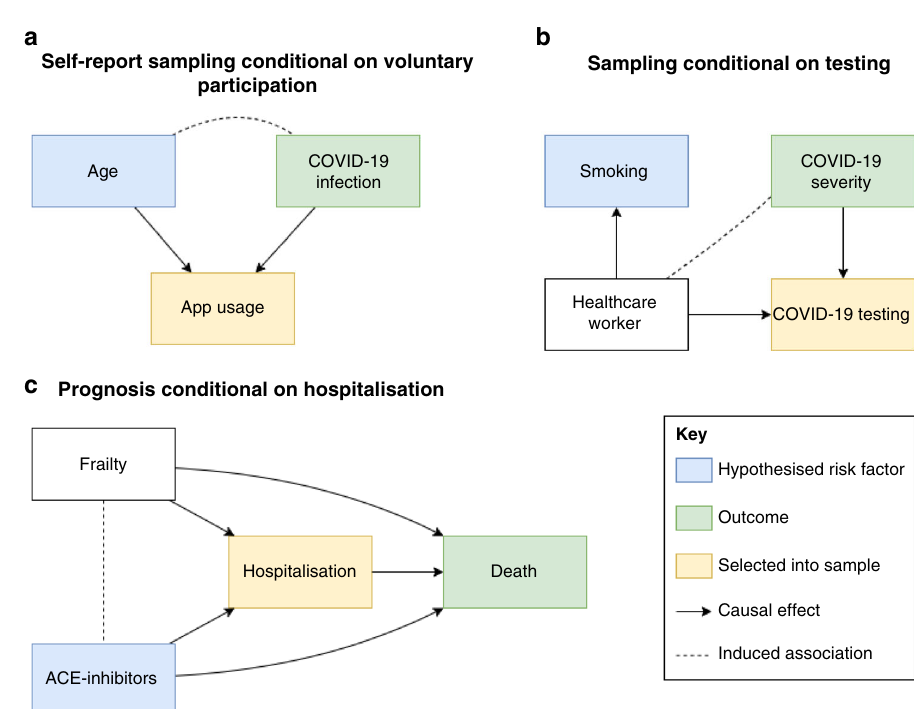
Fig. 2 Collider bias induced by conditioning on a collider in three scenarios relating to COVID-19 analysis. These are simpli fi ed Directed Acyclic Diagrams where only the main variables of interest have been represented for sake of illustrating collider bias scenarios. All assume no unspeci fi ed confounding or other biases. Rectangles represent observed variables and solid directed arrows represent causal effects. The dashed line represents an induced association when conditioning on the collider, which in these scenarios are variables that indicate whether an individual is selected into the sample. a When some hypothesised risk factor (e.g. age) and outcome (e.g. COVID-19 infection) each associate with sample selection (e.g. voluntary data collection via mobile phone apps), the hypothesised risk factor and outcome will be associated within the sample. The presence and direction of these biases are model dependent; where causes are supra-multiplicative they will be positively associated in the sample; where they are sub-multiplicative they will be negatively correlated, and where they are exactly multiplicative they will remain unassociated. We extend this scenario in b where the association between the hypothesised risk factor and the collider does not need to be causal. c When inferring the in fl uence of some hypothesised risk factor on mortality, in an unselected sample the risk factor for infection is a causal factor for death (mediated by COVID-19 infection). However, if analysed only amongst individuals who are known to have COVID-19 (i.e. we condition on the COVID-19 infection variable) then the risk factor for infection will appear to be associated with any other variable that in fl uences both infection and progression. In many circumstances, this can lead to a risk factor for disease onset that appears to be protective for disease progression. Each of these scenarios represents those described in the main